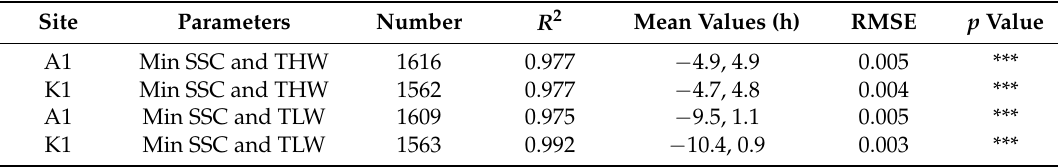
Figure 14. Time interval between the minimum SSC and the THW at stations A1 ( A ) and K1 ( B ) in 2007 and 2008.